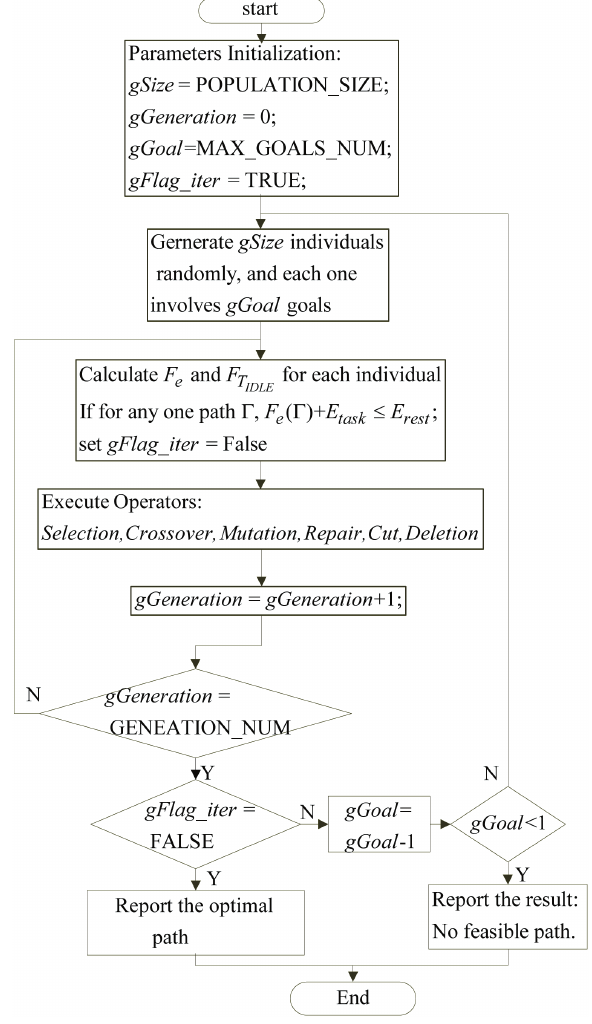
Fig. 6. Execution of the proposed genetic